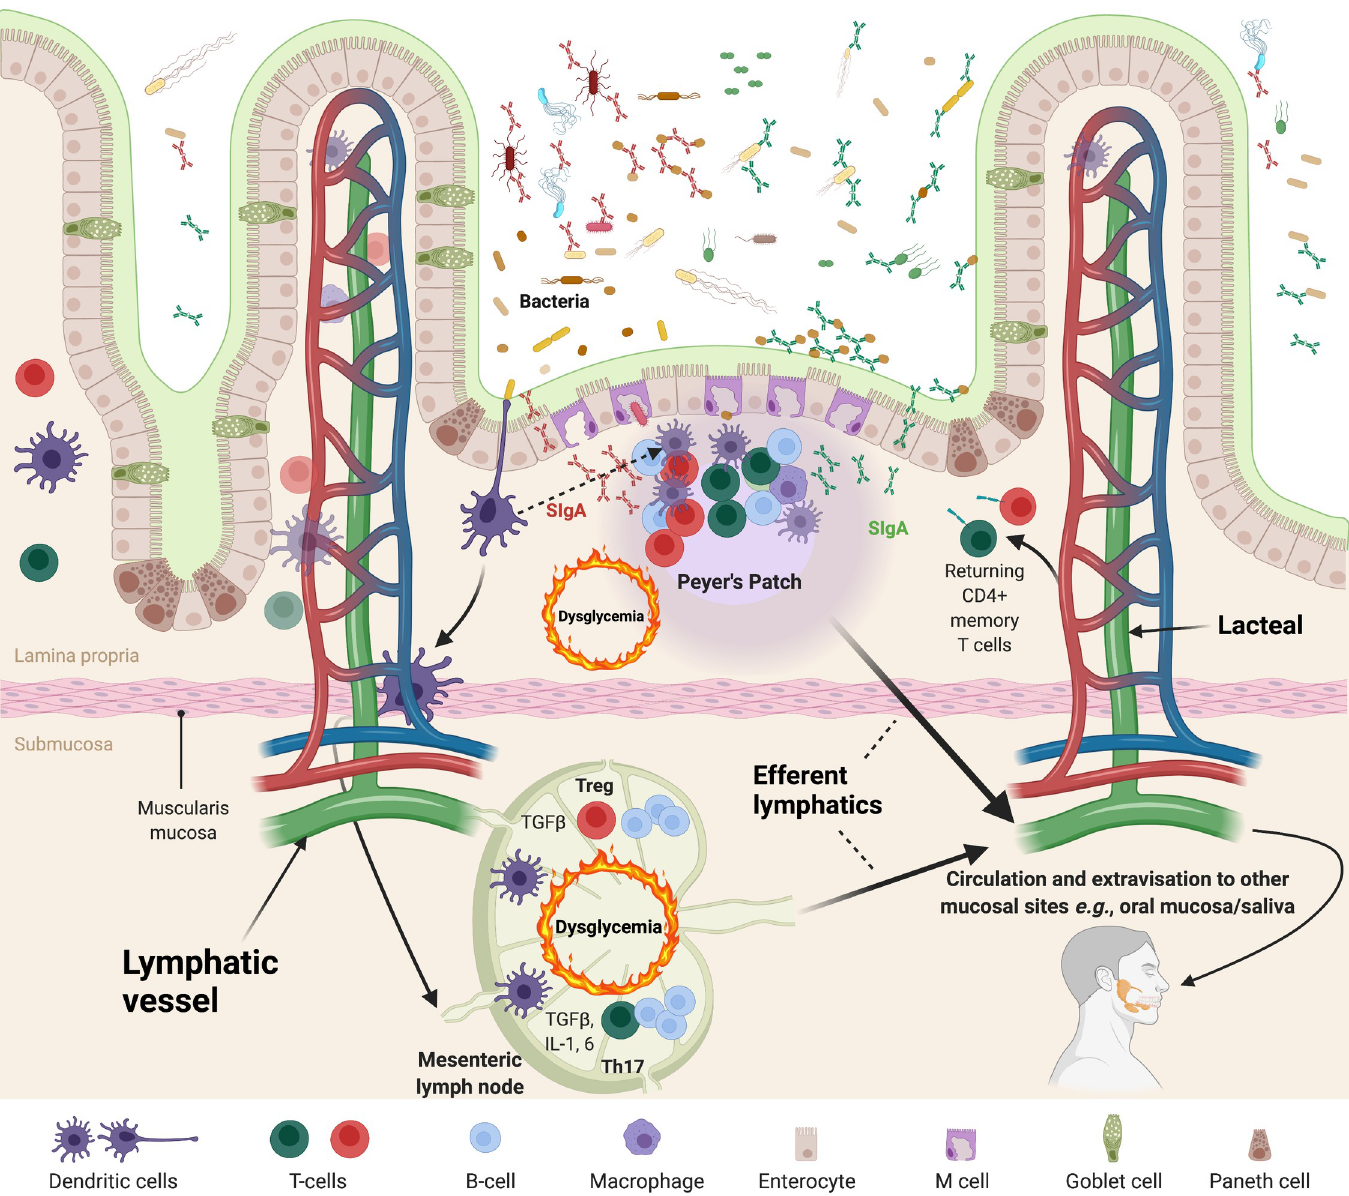
Fig 1. The Th17:Treg SIgA axis. IgA is produced at an approximate rate of 1 gram per day and is the primary acquired immune component secreted into mucosal surfaces [14]. Although B-cells populating these tissues can produce IgA without T-cell help (primarily in isolated lymphoid follicles; not depicted), somatic hypermutation resulting in the generation of affinity-matured (and highly specific) IgA is a product of germinal center reactions which involve T-cell help and take place almost exclusively within Peyer’s patches [14]. Because T-cells play a central role in the generation of affinity matured IgAs, the type of T-cell (Th17; green cells vs. Treg; red cells) providing B-cell help can impact the quantity and quality of the mucosal IgA response (red vs. green SIgAs and their respective targets). Therefore, the Th17:Treg-SIgA axis is likely to impact the IgA repertoire secreted into mucosal surfaces that in turn shapes the architecture of mucosal microbiomes. Inflammation and associated cytokine profiles triggered by chronic disease states like diabetes ( i . e .,dysglycemia) affect immune responses and can therefore alter Th17:Treg ratios and the resulting IgA response both in the gut and systemically. Activated T- and B-cells can migrate out of the gut via the efferent lymphatics and enter mesenteric lymph nodes or reach the circulation where they can migrate to other mucosal sites or return to the gut. T-cells in the circulation can then be isolated and Th17/Treg profiles defined. Created with Biorender.com. https://doi.org/10.1371/journal.pone.0258812.g001 between the Th17:Treg axis and the gut/salivary IgA-Biomes across the glycemic spectrum [40, 58–61]. Each qPCR assay is specific for either demethylated FOXP3 (for Tregs) or demeth- ylated IL17A (for Th17 cells) [40]. This technique provides relative and absolute immune cell